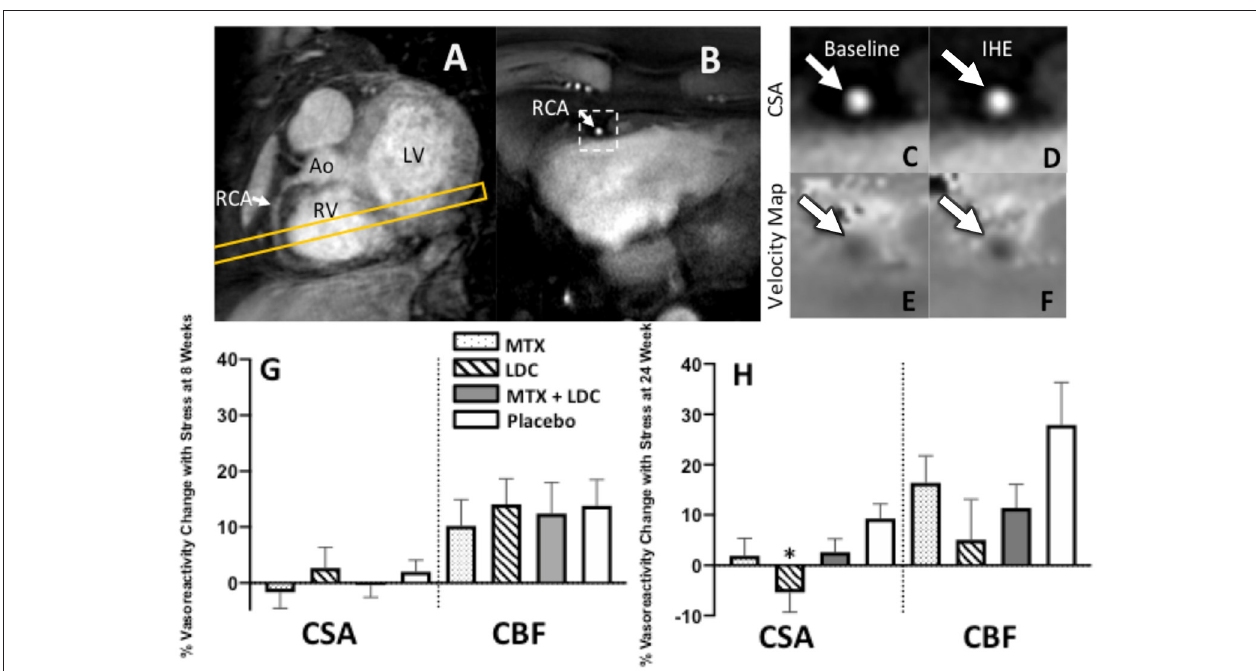
FIGURE 2 | Representative coronary artery MRI images for CEF. (A) A scout MRI obtained parallel to the right coronary artery (RCA) is shown with the location for subsequent cross-sectional imaging (yellow outline). (B) Image acquired along the yellow-outlined region in (A) with RCA in cross-section (white arrow). The dotted rectangle in (B) is magnified in subsequent panels and shows the region analyzed for cross-sectional area at rest (C) and during exercise (D) . Flow velocity images of the same segment at rest (E) and during IHE (F) using a phase contrast technique wherein signal darkness increases only slightly during IHE, indicating an impaired velocity response. (G,H) Relative changes (%) in coronary artery cross sectional area (CSA), and coronary blood-flow (CBF) detected by MRI during isometric handgrip exercise at 8 weeks (G) and 24 weeks (H) for those on methotrexate (MTX, black), colchicine (gray), MTX and colchicine (red), and placebo (blue). Error bars indicate standard error of the mean. There were no significant differences in coronary endothelial function parameters between the placebo and anti-inflammatory treatments at the 8 week (primary) end point. % CSA change was lower in colchicine than placebo (* p = 0.02) at 24 weeks. Ao, aorta; LV, left ventricle; RV, right ventricle.